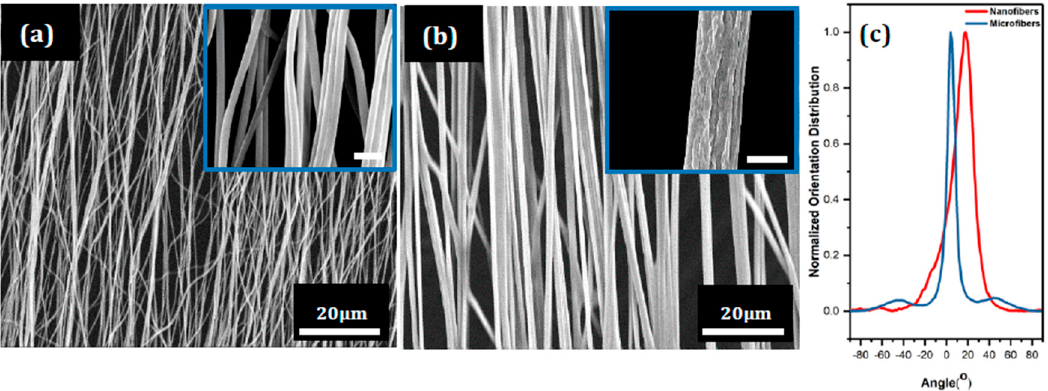
. Figure 2. As-spun aligned polyacrylonitrile fibers. ( a ) Nanofibers. Inset: higher magnification. ( b ) Microfibers. Inset: higher magnification. ( c ) Orientation distribution of both nanofibers and microfibers. Size of scale bars in inset images is 1 µ